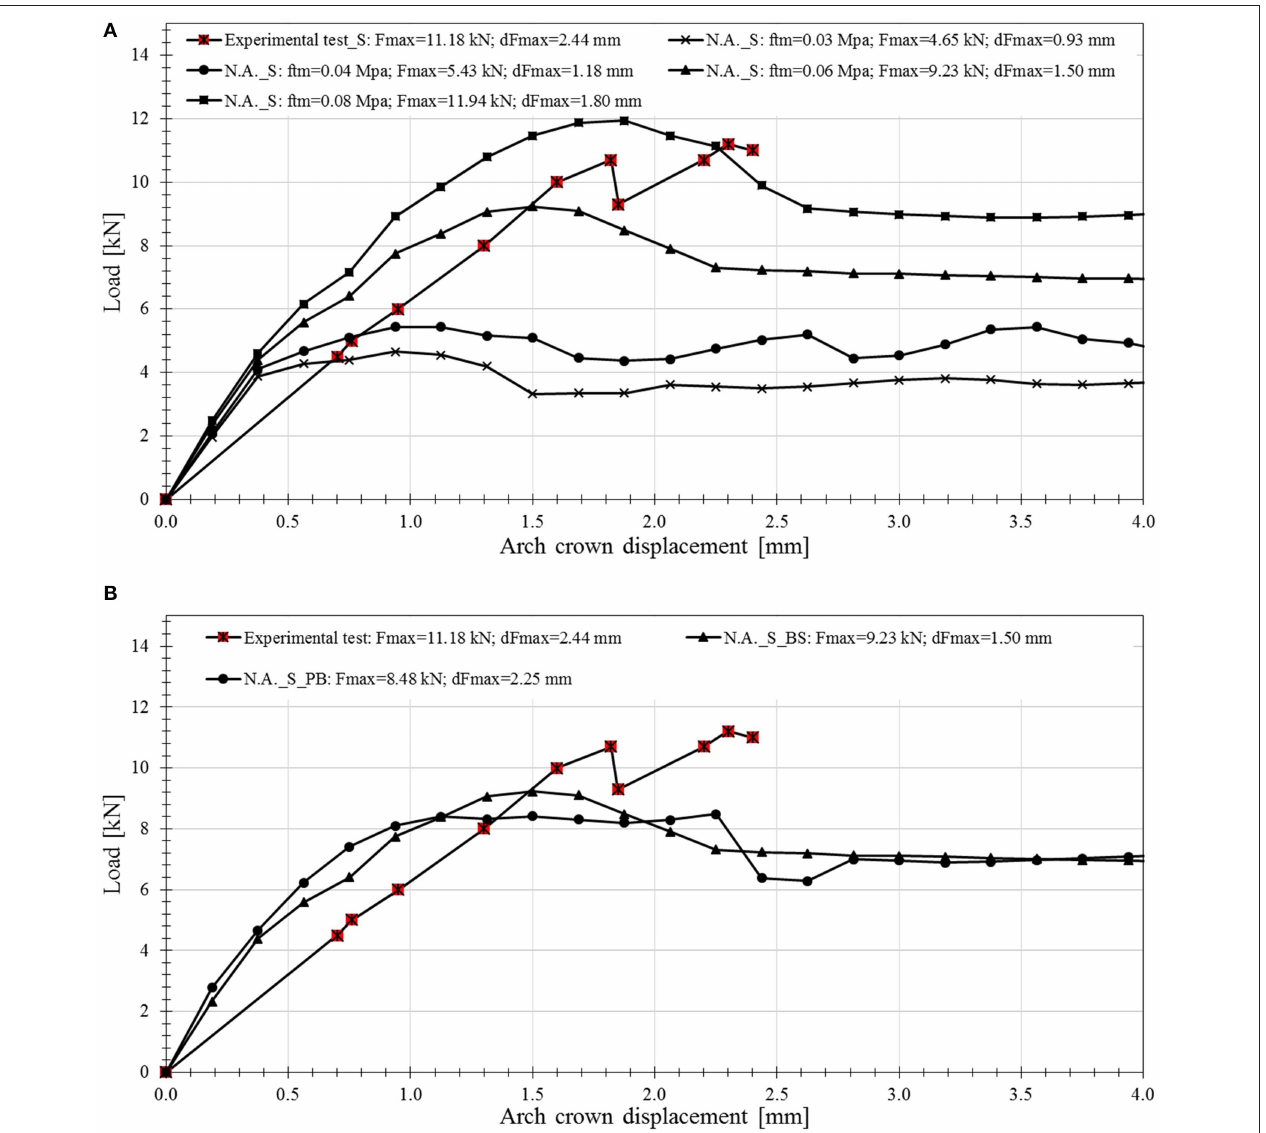
FIGURE 6 | Experimental and numerical Load-Arch crown displacement curves for the FRP-strengthened arch: (A) with f tm = 0.03, 0.04, 0.06, and 0.08 MPa; (B) with f tm = 0.06 MPa, and with (N.A._S_BS) and without (N.A._S_PB) perfect masonry-FRP